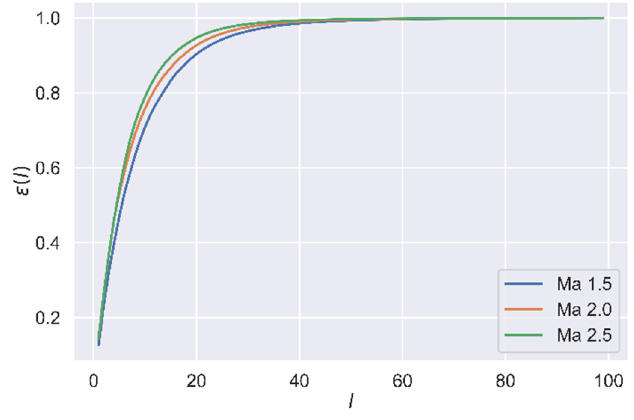
Figure 7. ℰ(ℓ) in the subzone behind the MVG in three different Mach numbers.